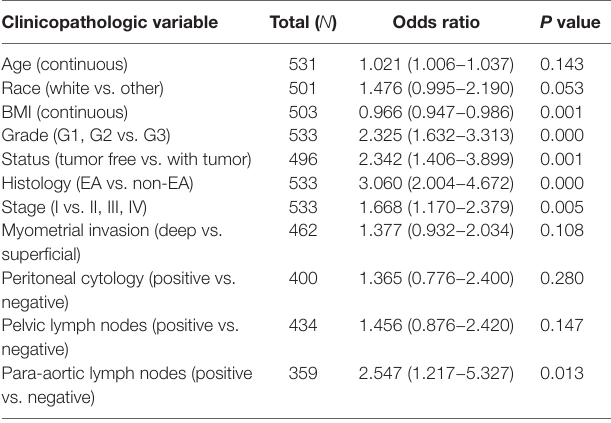
TABLE 6 | a . Overall survival and associations with clinicopathologic characteristics using Cox regression. b. Multivariate survival model after variable selection.